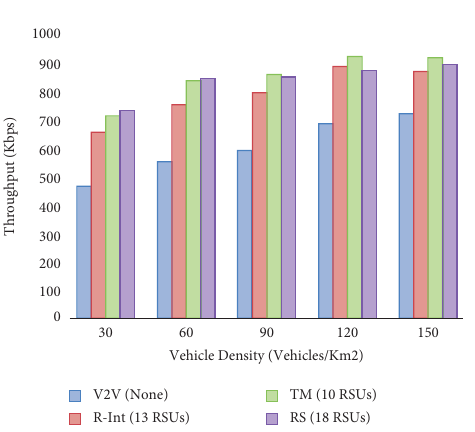
Figure 24: Delay